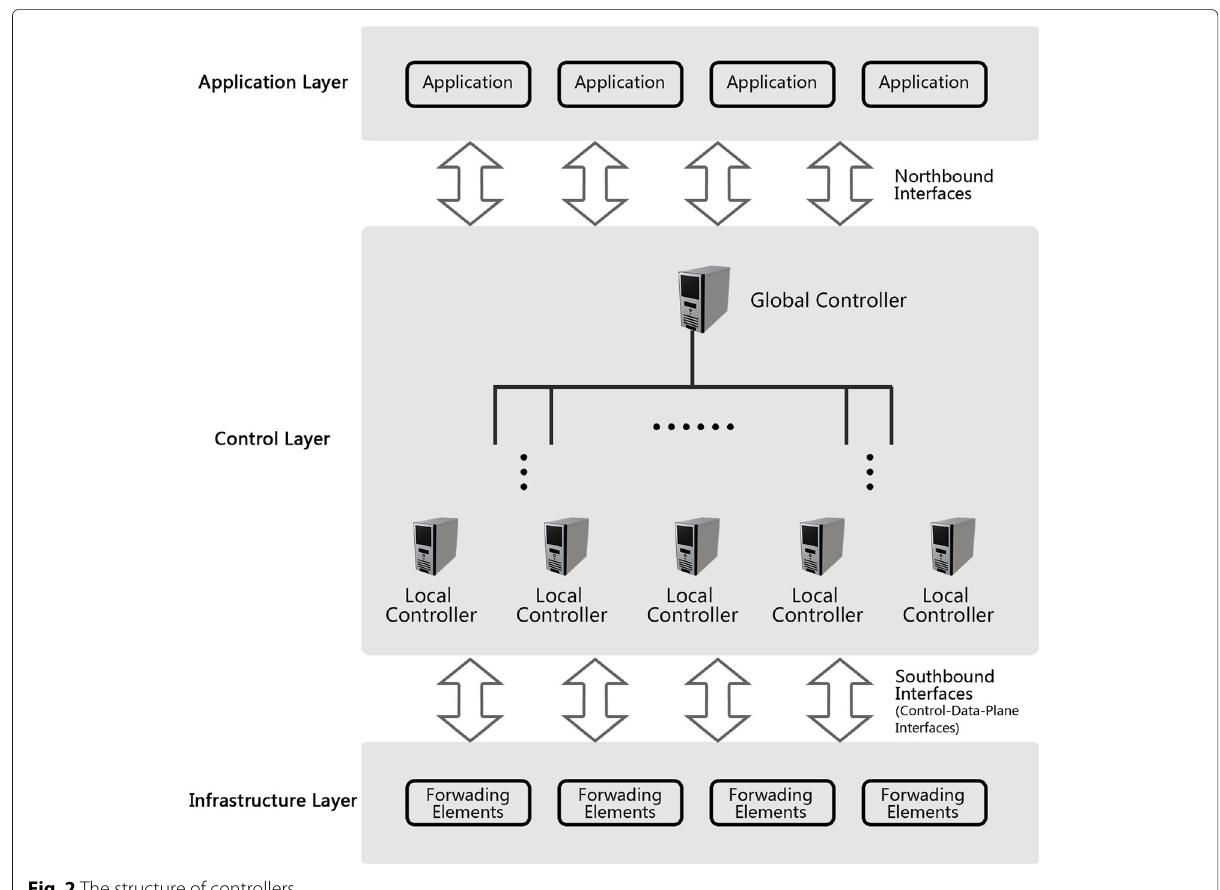
Fig. 2 The structure of controllers 2 When received requested messages from vehicles, the LC will return security parameters and corresponding CFSs according to preloaded road maps and conditions of vehicles. The main elements that should be considered in our environment